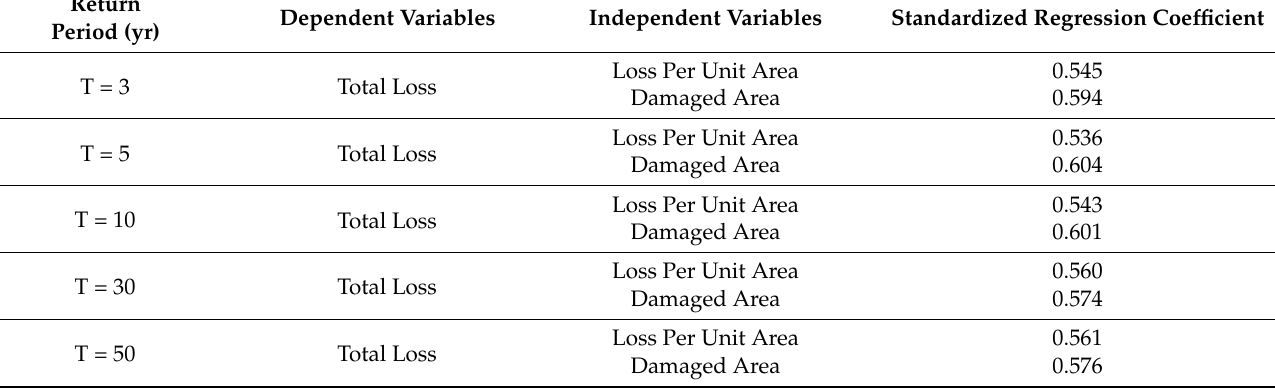
Table 5. The standardization regression analysis results of total loss, loss per unit area, and damaged area under different return